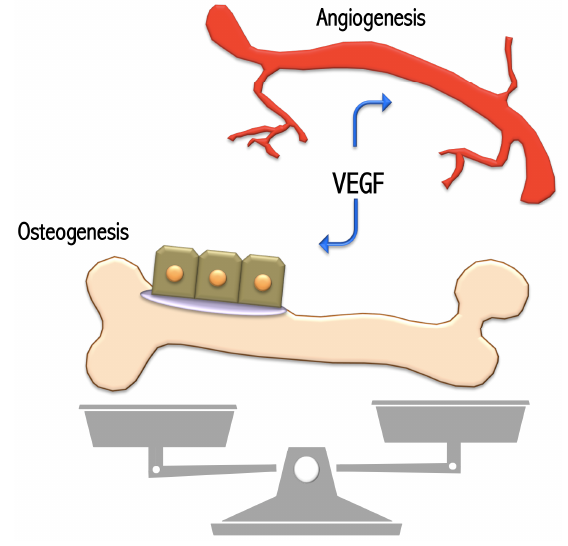
Figure 1. Relevant events regulated by VEGF signal.